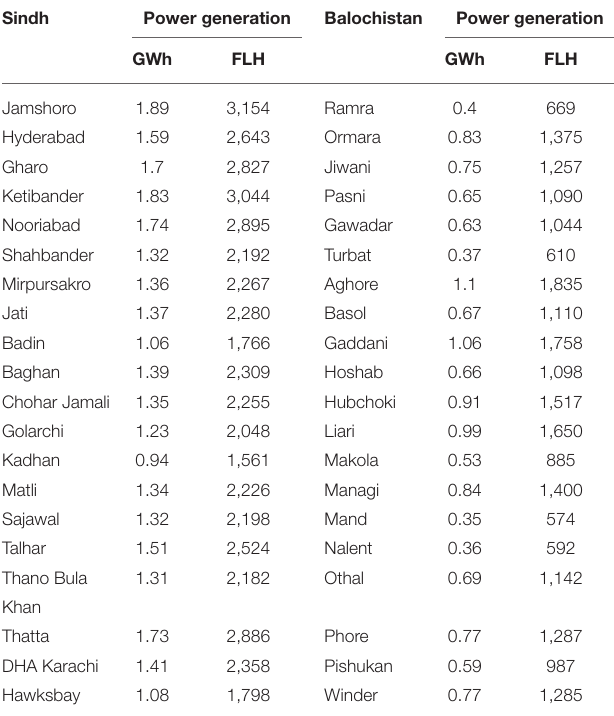
TABLE 3 | Estimated wind power generation capacity of Pakistan (Harijan et al., 2009, 2011). Sindh Power